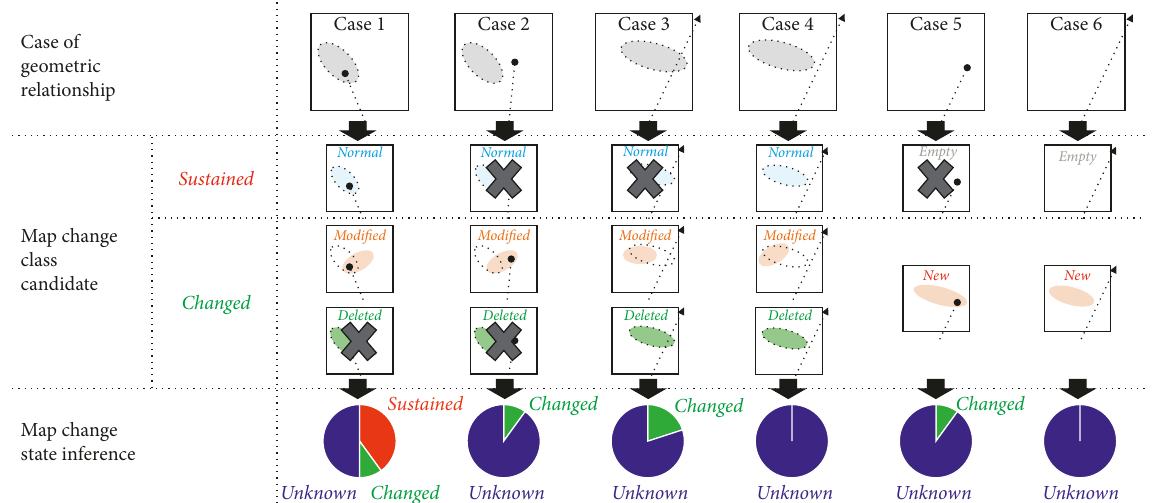
Figure 9: Evidence modeling based on six cases for geometric